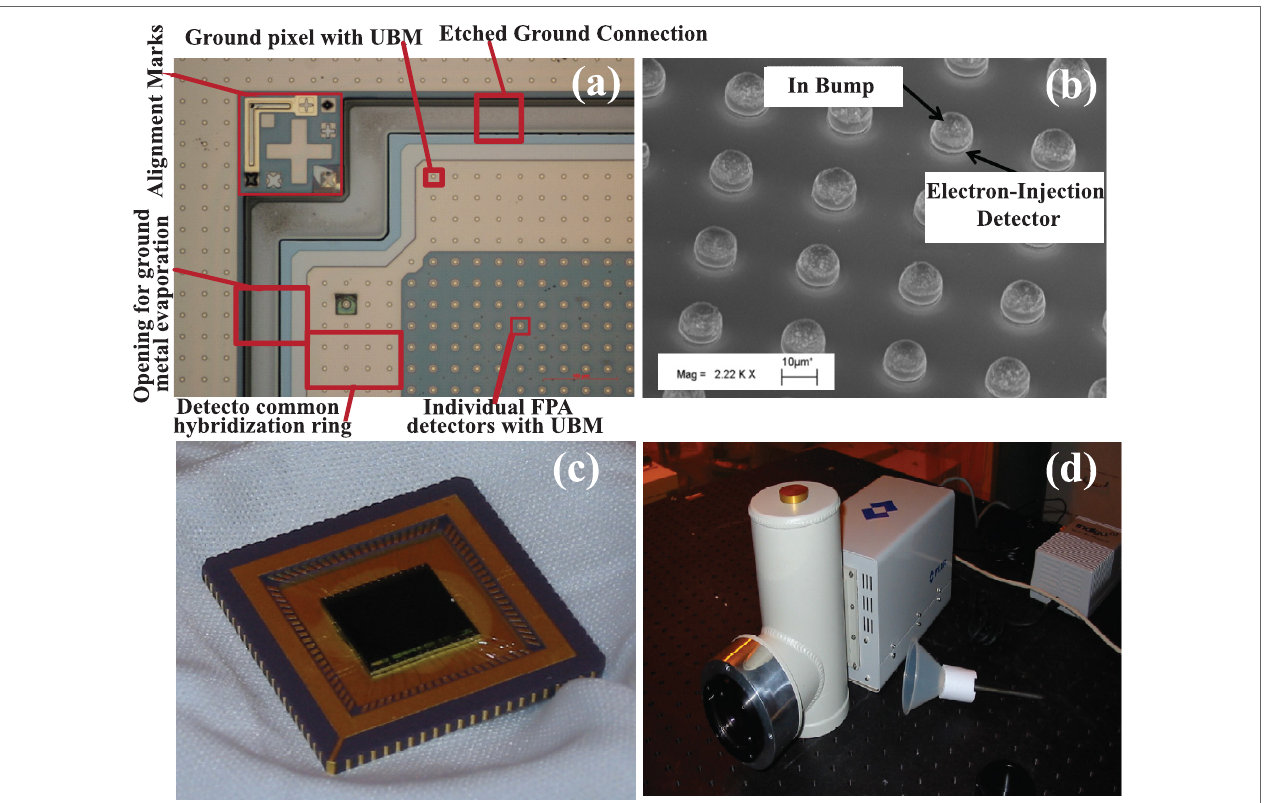
FiGURe 7 | (A) Optical Microscope image of electron-injection imager showing the focal plane array, the detector common hybridization ring, Under-Bump- Metallurgy (UBM) for Indium plating and alignment marks. (B) SEM image of the detectors with indium bumps on top ready for integration (Memis et al., 2010b) (C) A picture of the final electron-injection imager on a leadless chip carrier (D) A picture of the infrared camera housing. Reproduced with permission from Memis et al.